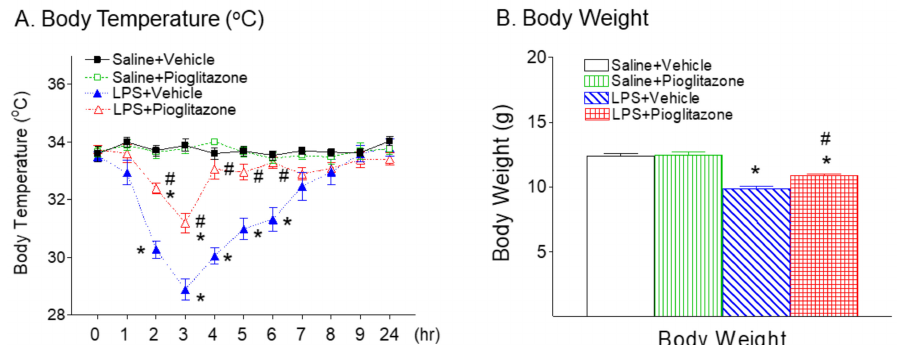
Figure 1. Pioglitazone attenuated neonatal LPS-induced hypothermia ( A ) and body weight loss ( B ) in the rat. The results are expressed as the mean ± SEM of eight animals in each group and analyzed by two-way repeated measures ANOVA for data from tests conducted continuously at different hours after LPS injection ( A ), or two-way ANOVA ( B ), followed by the Student–Newman–Keuls test. * p < 0.05 represents a significant difference for the LPS + Vehicle group or LPS + Pioglitazone group as compared with the Saline + Vehicle group. # p < 0.05 represents a significant difference for the LPS + Pioglitazone group as compared with the LPS + Vehicle